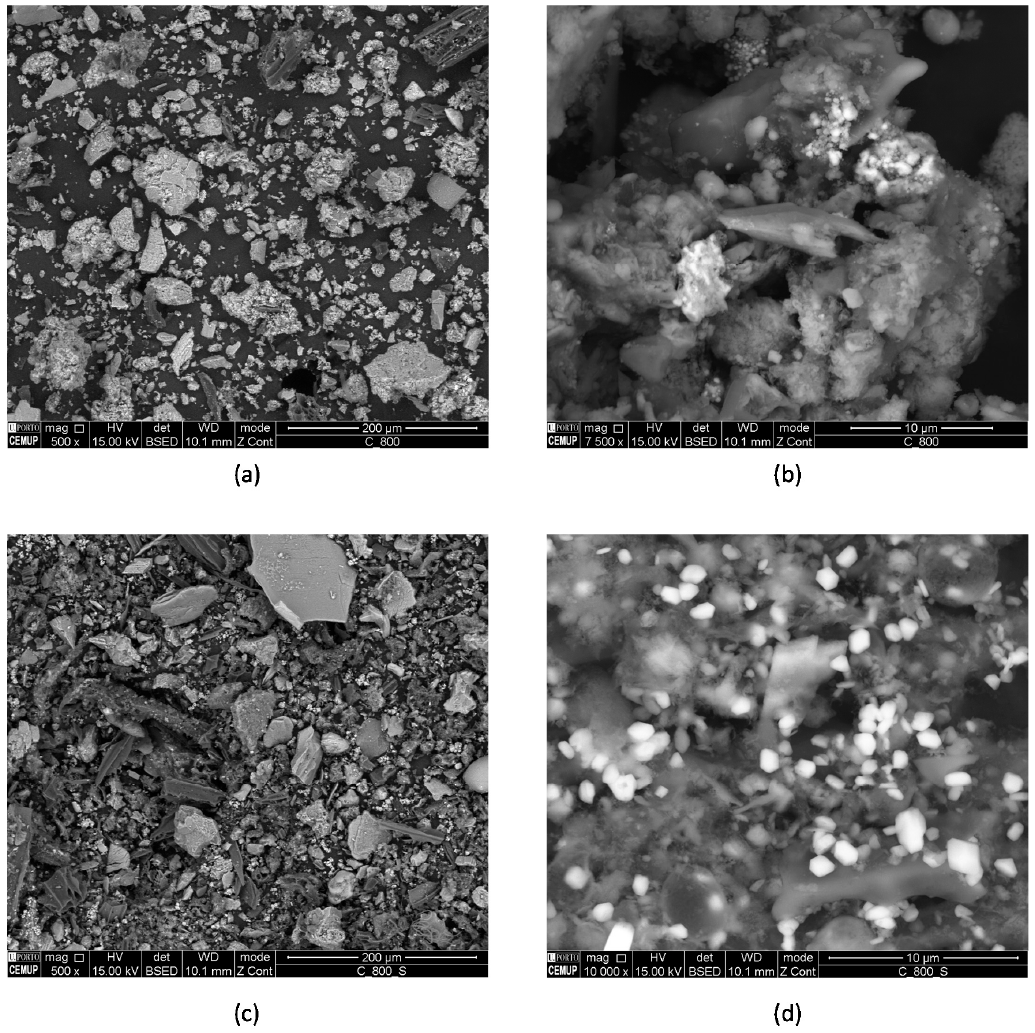
Figure 2. Scanning electronic microphotographs of the C-800 ( a , b ) and C-800-S ( c , d ).